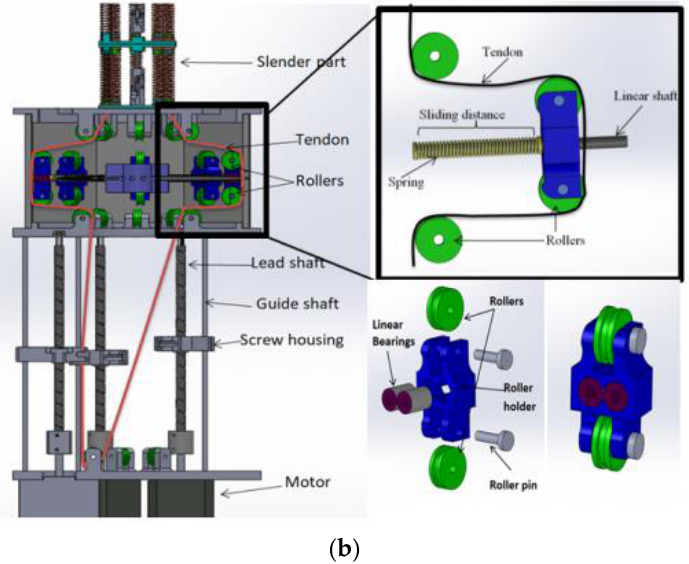
Figure 4. TakoBot pretension mechanism design and structure. ( a ) Pretension mechanism CAD view; ( b ) Wire routing schematics and pretension device structure.